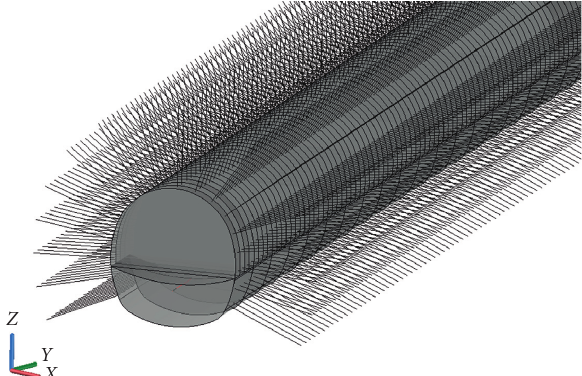
Figure 11: Model of a tunnel with rock